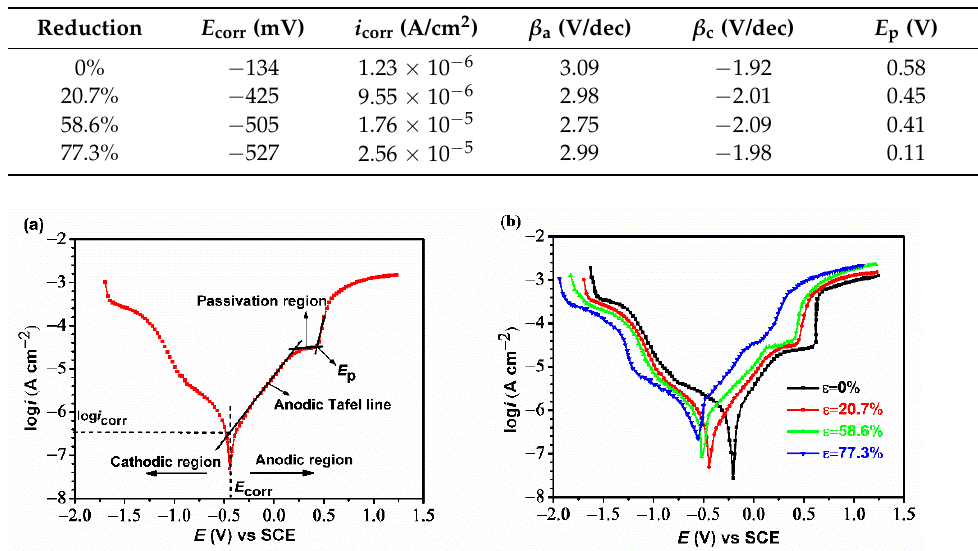
Table 5. Potentiodynamic polarization parameters of Cu electrodes under different rolling reduction.